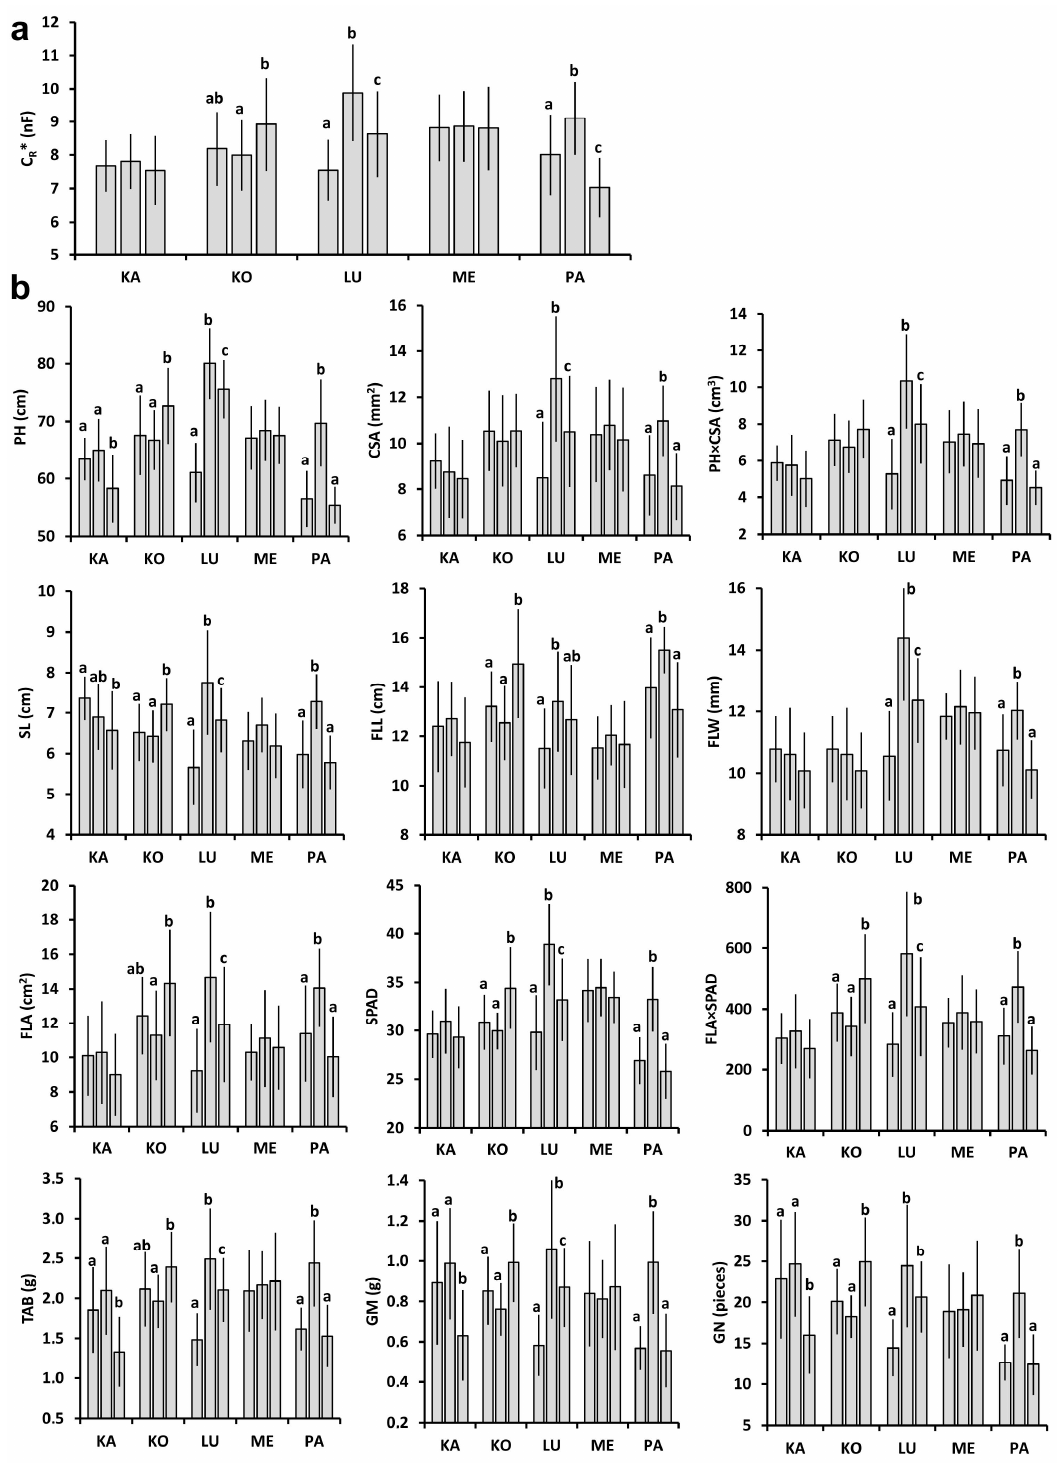
Figure 1. Measured plant parameters (mean ± SD; n = 20) for the five wheat cultivars (KA: Káplár; KO: Kolo; LU: Lucilla; ME: Ménrót; PA: Pántlika) in three replicate plots (A, B, and C from left to right) in 2021. Different lower-case letters indicate significant differences (ANOVA with Tukey’s post hoc test) between the three plots within a cultivar. ( a ) C R *: saturation root electrical capacitance; ( b ) PH: plant height; CSA: stem cross-sectional area; SL: spike length; FLL: flag leaf length; FLW: flag leaf width; FLA: flag leaf area; SPAD: chlorophyll content in flag leaf; TAB: total aboveground biomass; GM: grain mass; GN: grain number.